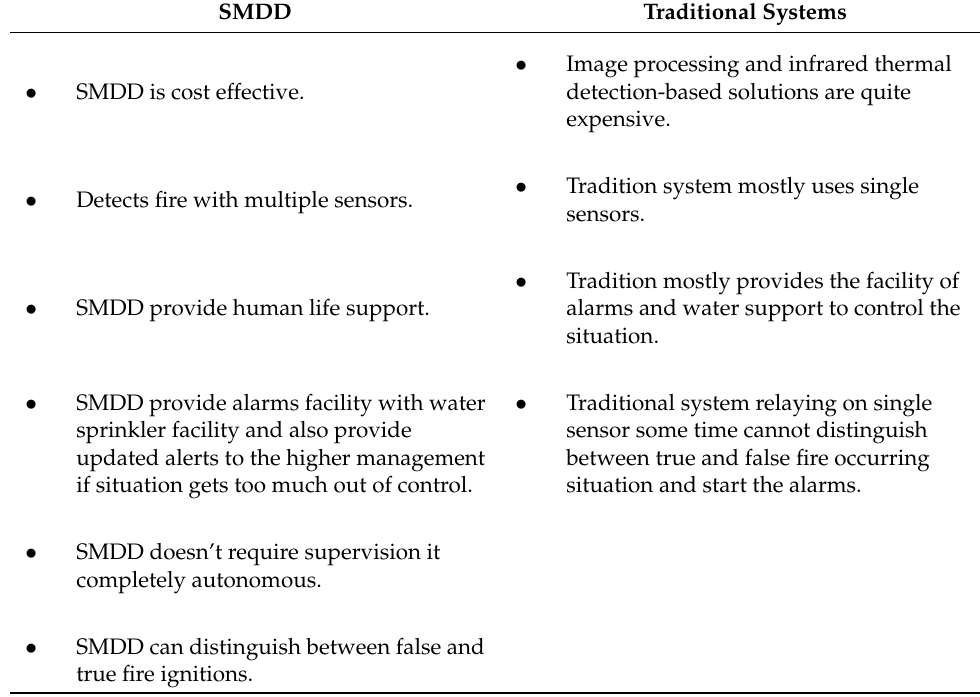
Table 10. Advantages of SMDD over traditional